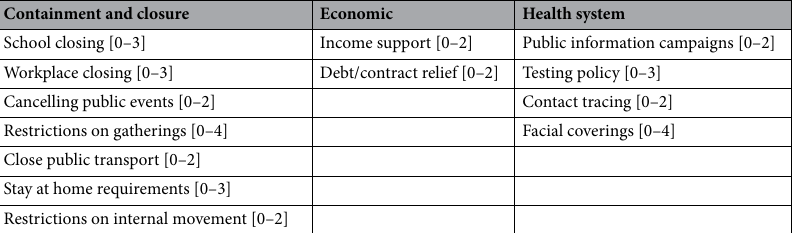
Table 1. 13 government policies to mitigate the pandemic used in the mathematical model. Numbers in brackets represent the original value ranges of each policy.